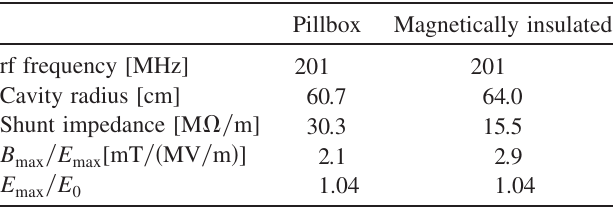
TABLE II. Characteristics of the rf system. Pillbox